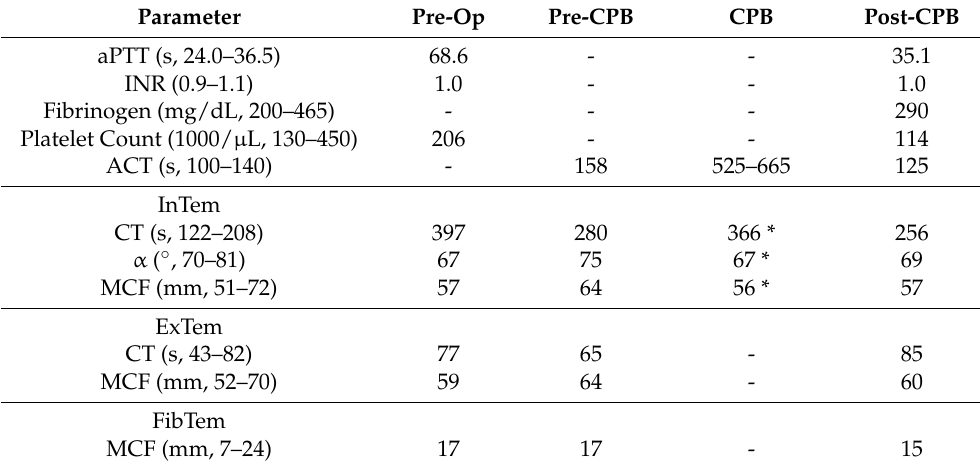
Table 1. Perioperative hemostatic